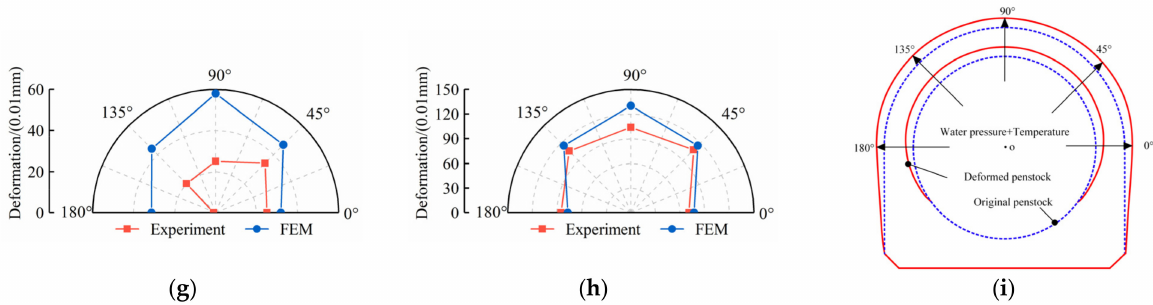
Figure 17. Radial displacement under finite element model and test model subjected to different tempera- ture gradients: ( a ) A1; ( b ) A2; ( c ) A3; ( d ) B1; ( e )B2; ( f ) B3; ( g ) C1; ( h ) C2; ( i ) internal water